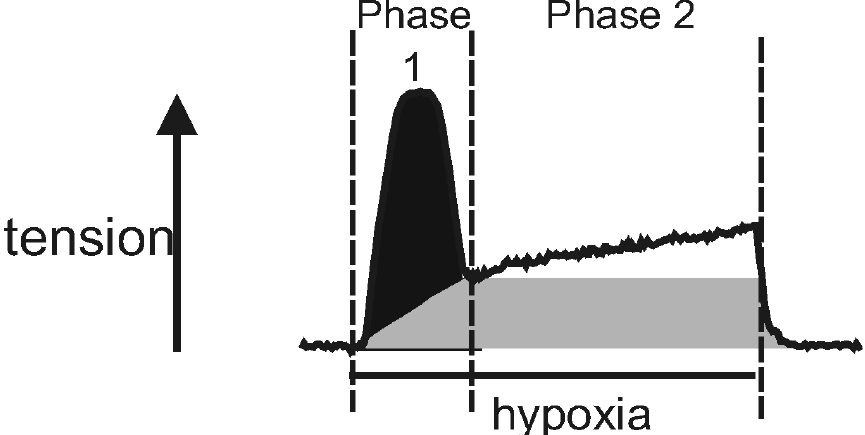
Figure 2. Schematic diagram that describes the two phases of hypoxic pulmonary vasoconstriction (HPV) triggered upon exposure of an isolated pulmonary artery ring to hypoxia. Phase 1 is driven by the smooth muscle (black). Phase 2 is driven by the smooth muscle (grey) and amplified through an endothelium-dependent mechanism (white).